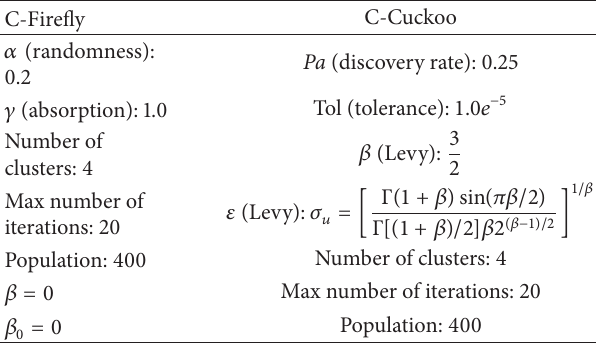
Table 5: Parameters set for C-Firefly and C-Cuckoo.